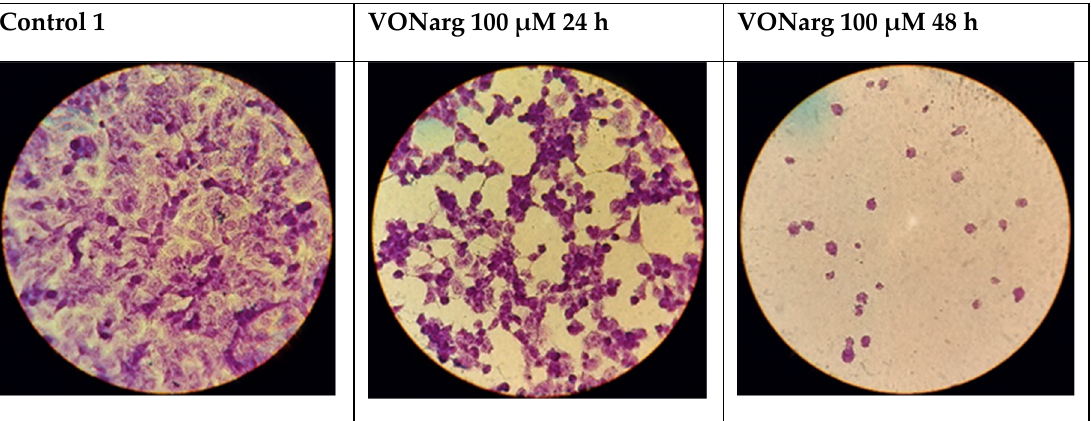
Figure 5. Effect on cell morphology for the treatment of A549 cell line with VONarg. Cells were incubated for 24 and 48 h without drug additions (control) and with the complex (100 µ M, 400 × g magnification).